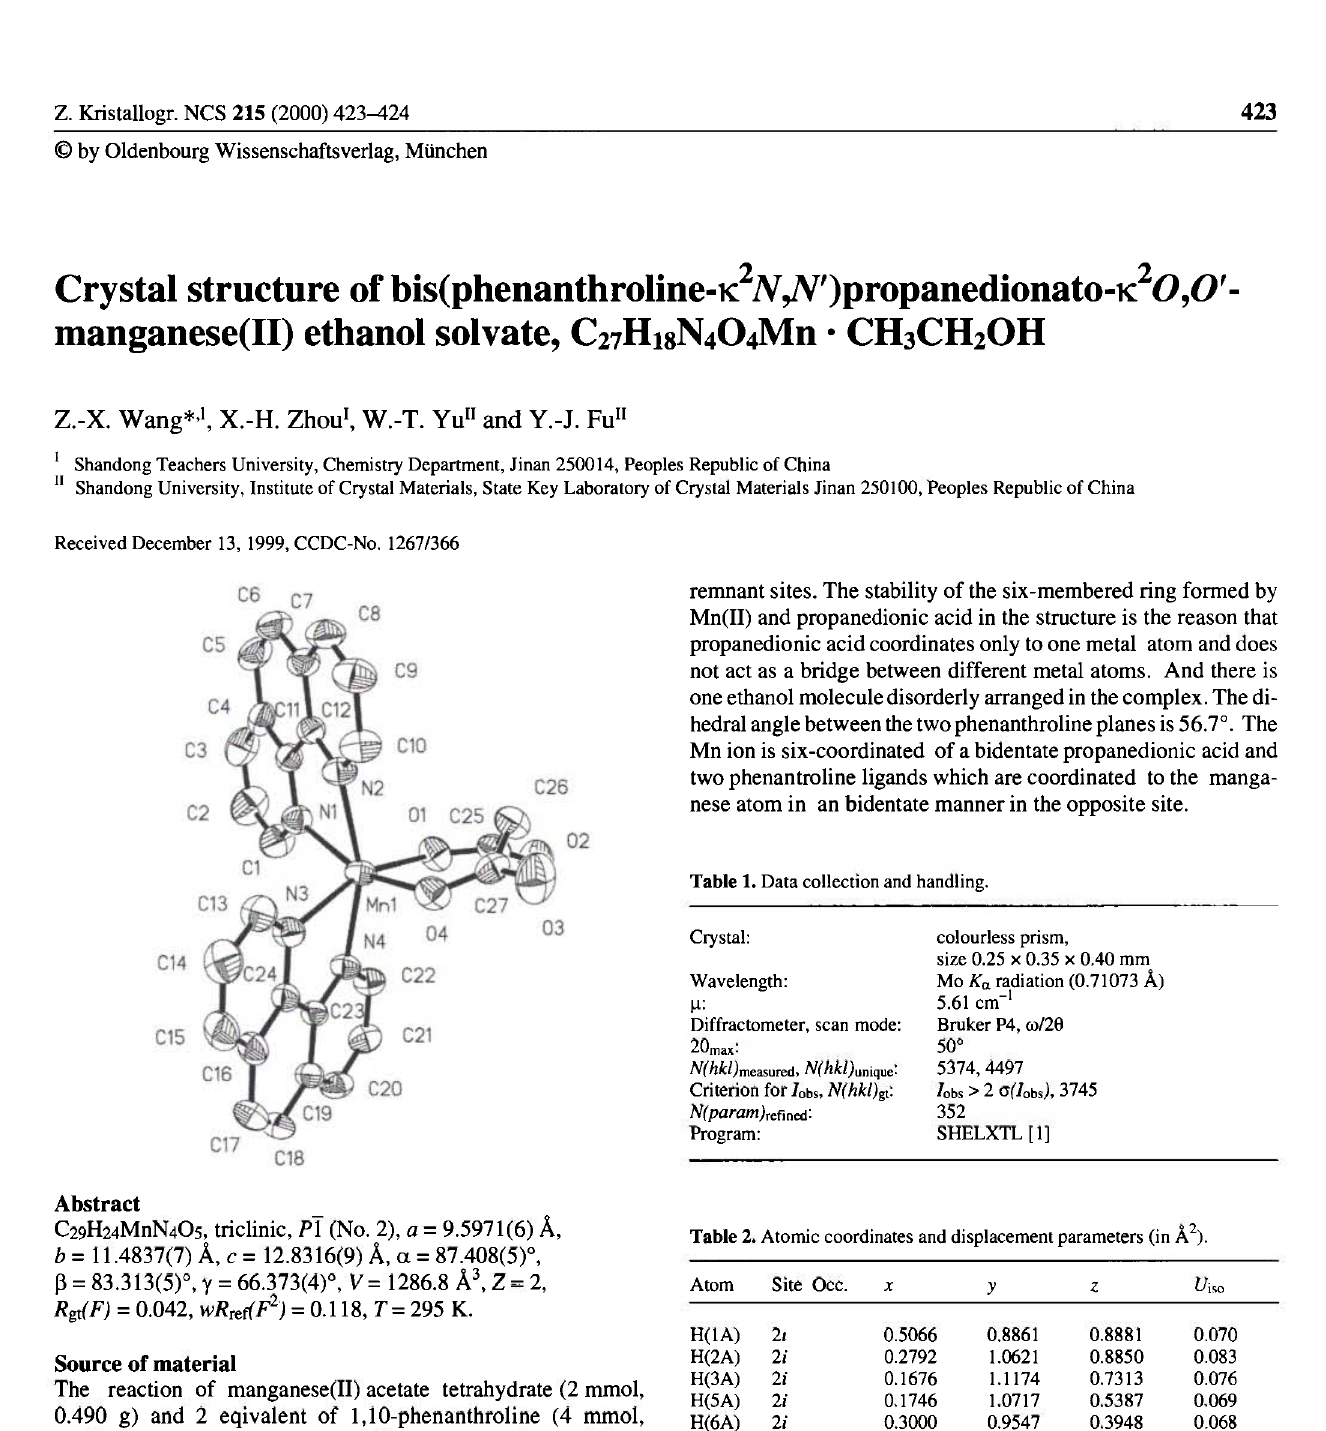
Table 2. Atomic coordinates and displacement parameters (in Ä 2